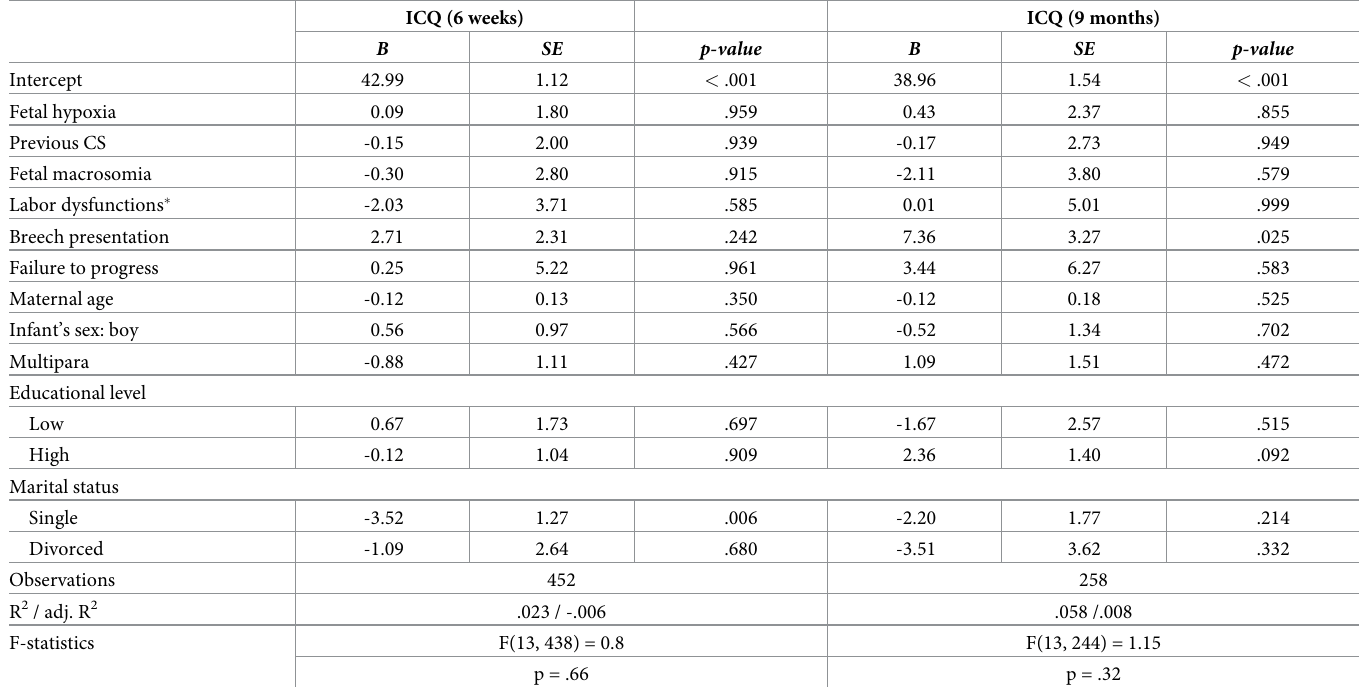
Table 4. Association between indications for cesarean section and infant temperament—Adjusted for sociodemographic factors, parity, and infant’s